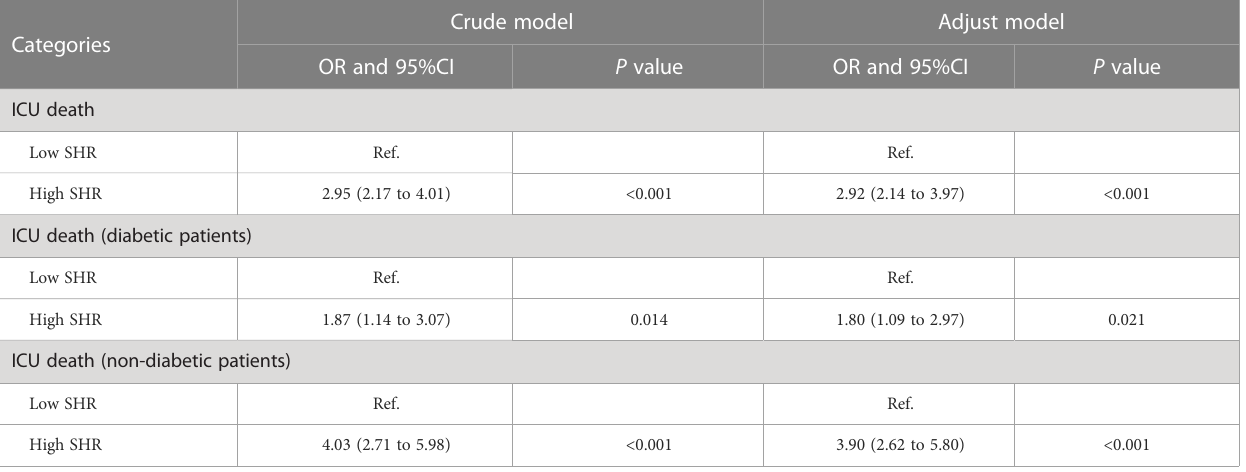
TABLE 2 Association between the ICU death and